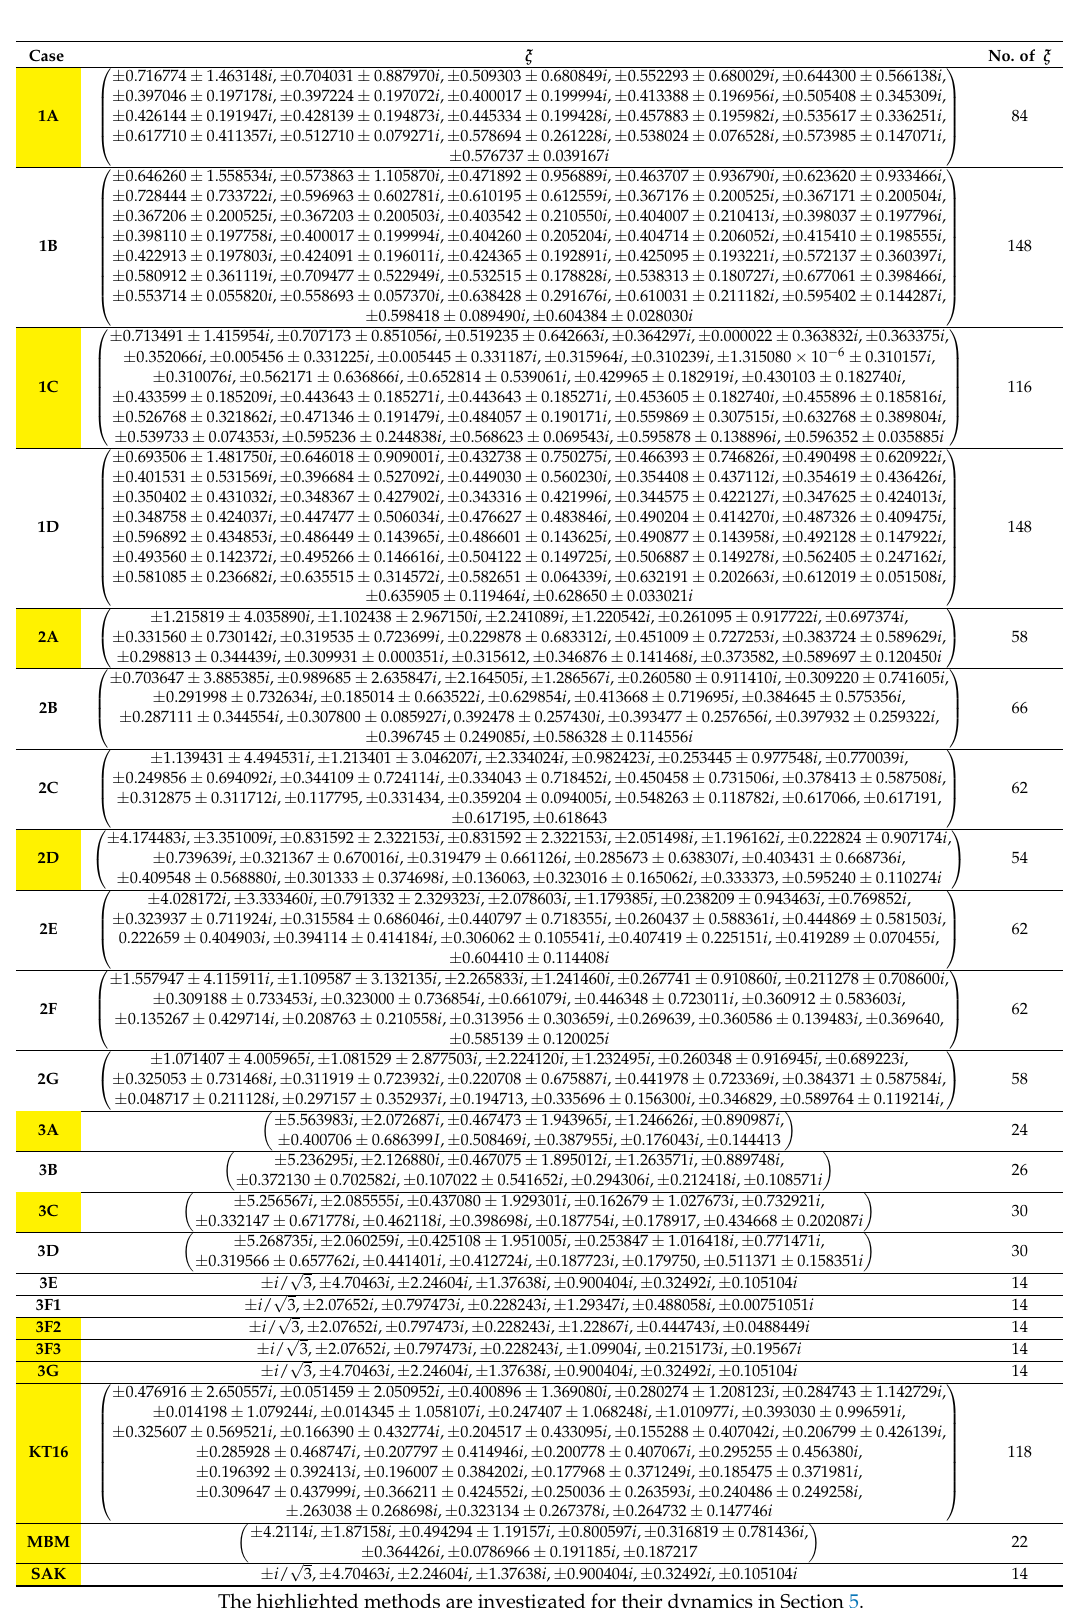
Table 1. Indifferent extraneous fixed points ξ for selected